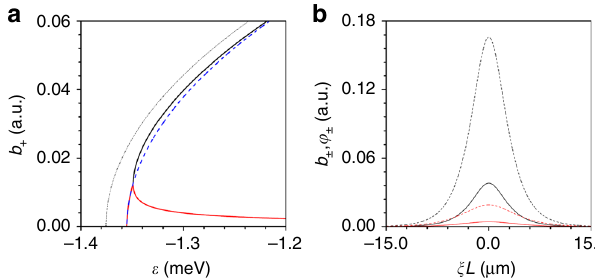
Fig. 2 Polariton dispersion and Cherenkov resonances. Energy-momentum (or dispersion) characteristic of the lowest-energy modes is shown with solid red (TE mode) and black (TM mode) lines: ε = ħ ω R δ vs. polariton momentum k L − 1 . The approximate dispersion giving the exact solitons is shown with the dotted lines. The grey shaded area represents continuous spectrum. Two straight lines show examples of the dispersion characteristic of the exact solitons with δ = − 0.35, k s = 1.2, v = 0.366 (soliton spectrum centred at ≃ 2 μ m − 1 , Cherenkov resonance at ≃ 0) and δ = − 0.24, k s = 1.5, v = 0.150 (soliton spectrum centred at ≃ 2.4 μ m − 1 , Cherenkov resonance at ≃ − 0.9 μ m − 1 ). The open circles show the Cherenkov resonances, representing solutions of Eq. (12)